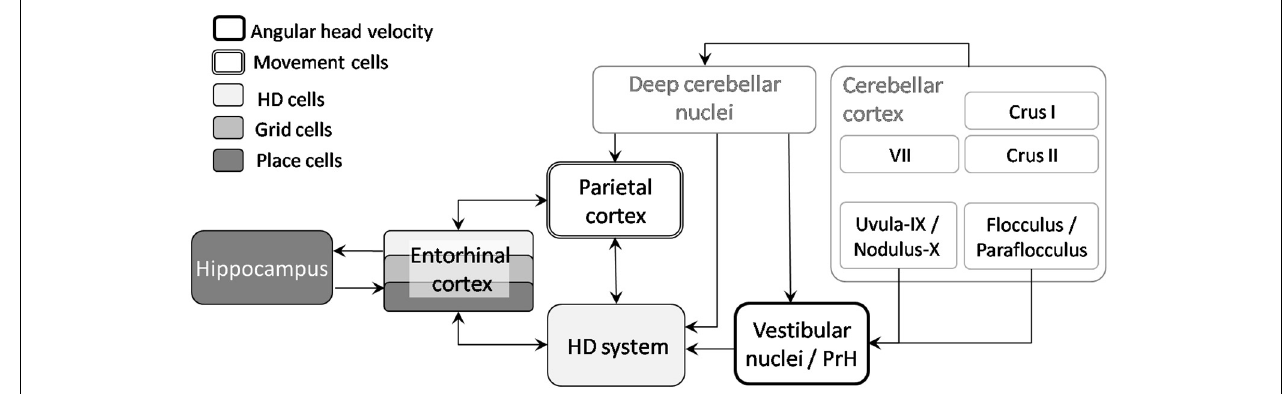
FIGURE 5 | From cerebellum to navigation-related structures. Two pathways could sustain the influence of the cerebellum on place cells activity: the projection of lobule IX-X-floculus-parafloculus through vestibular nuclei to